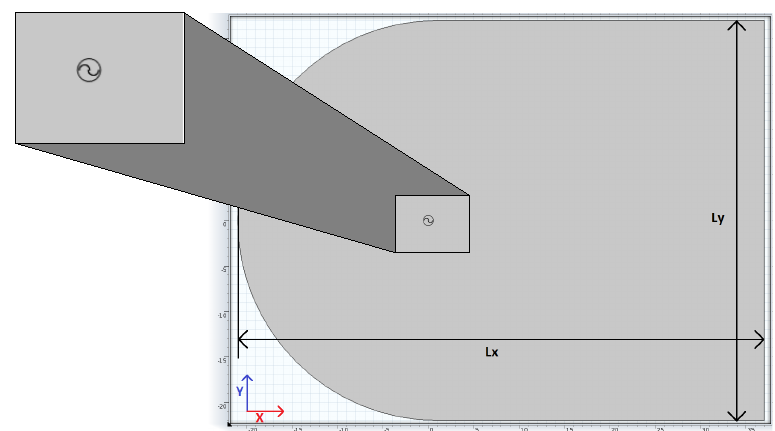
Figure 2. Geometry of the control